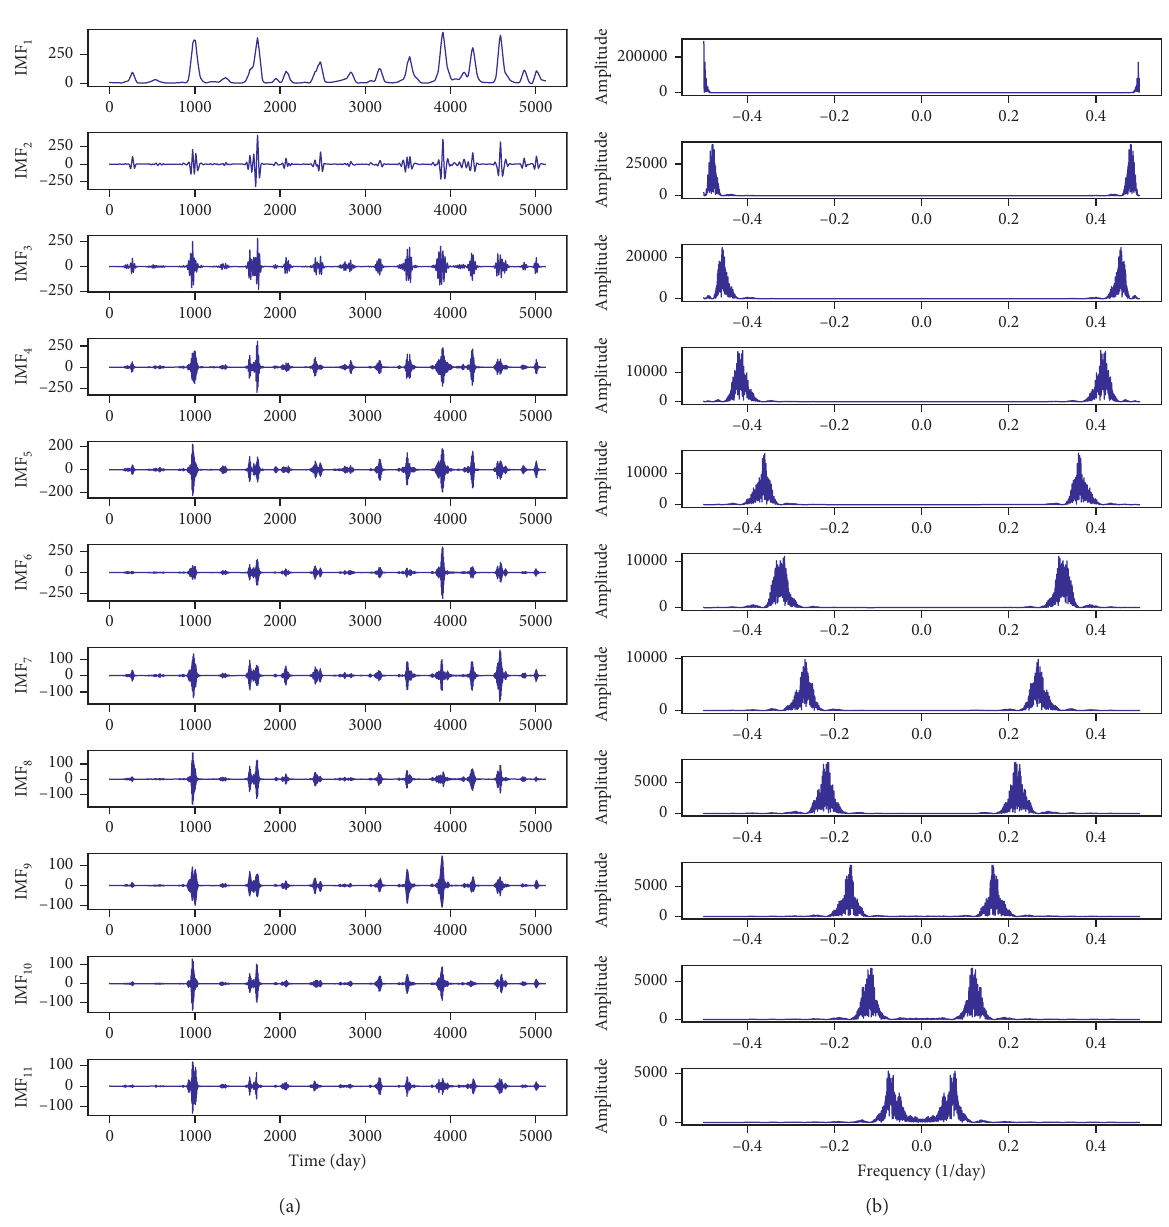
Figure 4: The decomposed subseries results of the daily streamflows using VMD at the Weijiabao station: (a) the decomposition sequence waveform and (b) the frequency spectrum